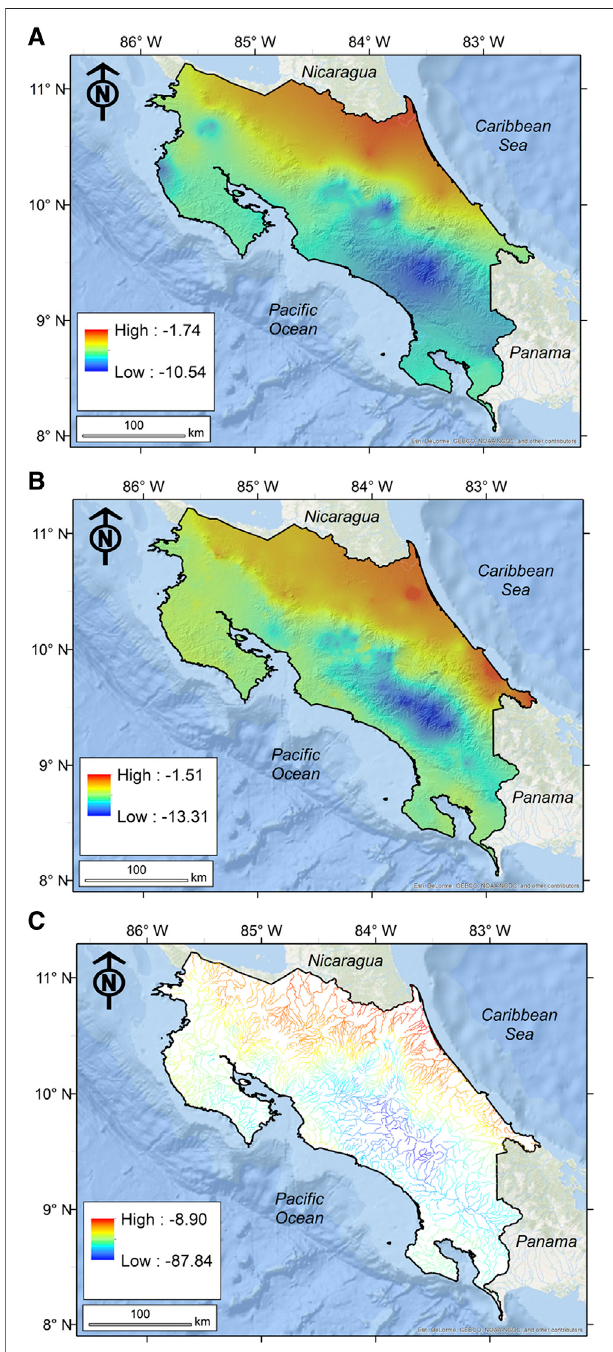
FIGURE 11 | Rainfall and groundwater annual spatial variations. Interpolated δ 18O (A) rainfall, (B) groundwater, and (C) surface water isoscapes(Sánchez-MurilloandBirkel,2016).Figureadaptedusingdatafrom Sánchez-Murillo and Birkel (2016).